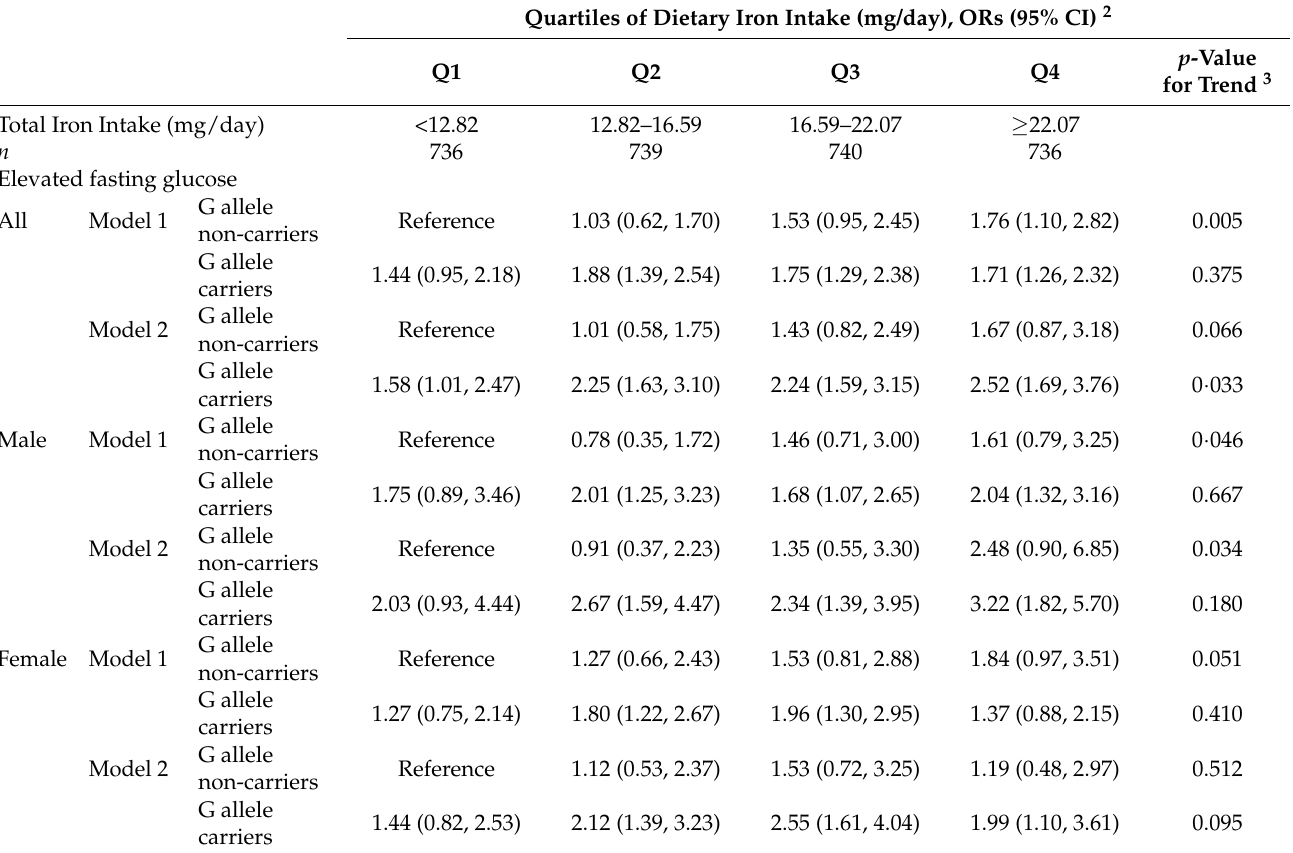
Table 3. ORs (95% CIs) for elevated fasting glucose according to the quartiles of dietary iron stratified by the rs10830963 risk allele in the MTNR1B gene among the participants 1 . Quartiles of Dietary Iron Intake (mg/day), ORs (95% CI)